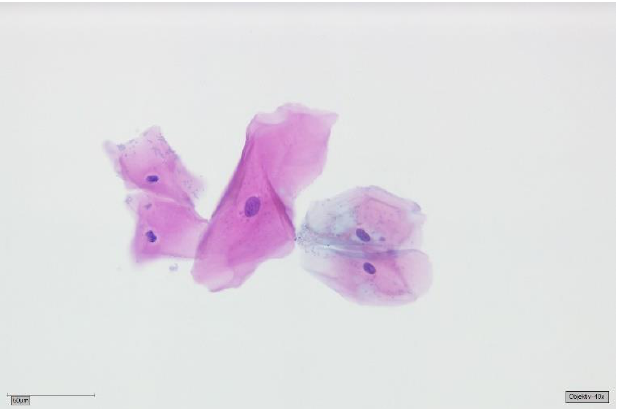
Figure 2. Negative for tumour cells — SurePath, staining Papanicolaou, lens 40×. Clinically most probably oral lichen planus (OLP). The background is completely clear. Bacterial flora can still be appreciated clinging to the cell surfaces. A group of five mature squamous cells with reactive changes: cytoplasmic hypereosinophilia and amphophilia, and megalocytosis of the central cell with corresponding mild nuclear enlargement. Small perinuclear halos of the two cells in the left field. All nuclei are round to ovoid with smooth contours and finely granular, evenly dispersed chromatin.